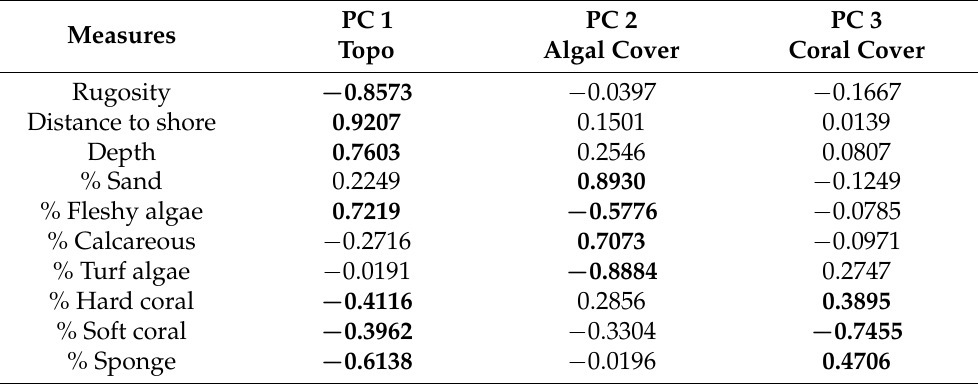
Figure 3. Log n (ln) mean per structure of the counts for all reef fishes combined (gray) and for each functional group— herbivores (green), omnivores (orange), predators (blue), and invertivores (yellow)—obtained during the time-lapse photography observations on the different natural and artificial corals. Error bars are ± 1 SEM. Differences in the letter located over each bar indicate when values were shown to be statistically different from one another by Tukey’s post hoc comparisons. Table 1. Principal component score correlations for reef substrate measures. Bold indicates loadings with p <